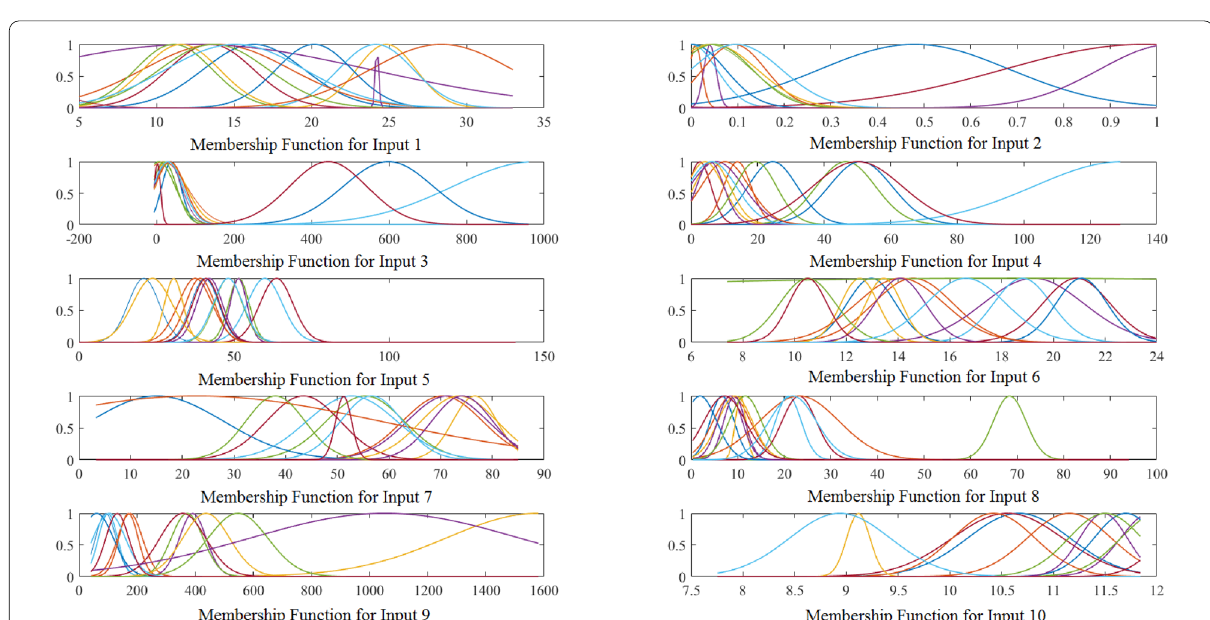
Fig. 18 Gaussian membership functions of input parameters after the training process by